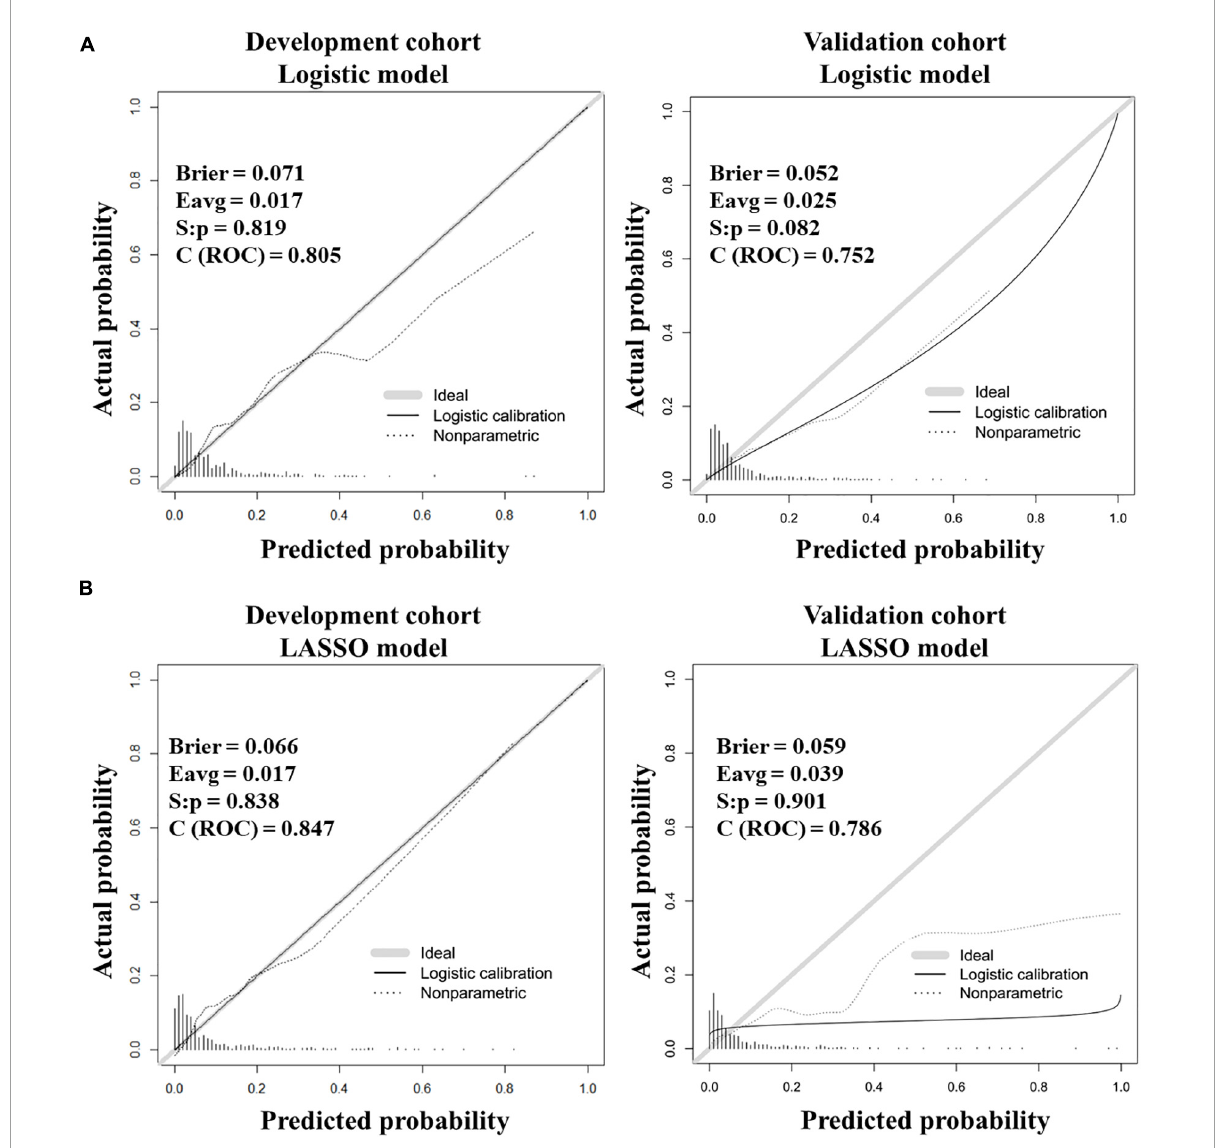
FIGURE3 Calibration curves for testing the stability of prediction models in the development and validation cohorts. (A) Calibration curves for the logistic model. (B) Calibration curves for the LASSO